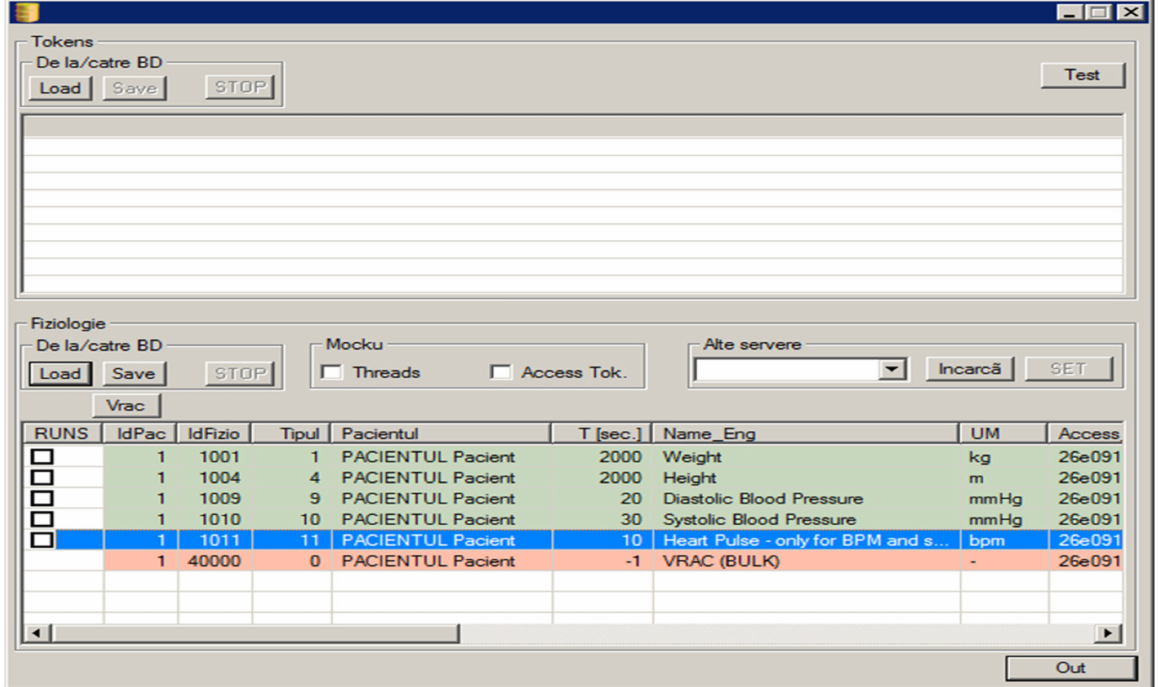
Figure 10. Illustration of the result of the application designed to obtain health parameter measure- ments for a certain patient performed with a set of Withings